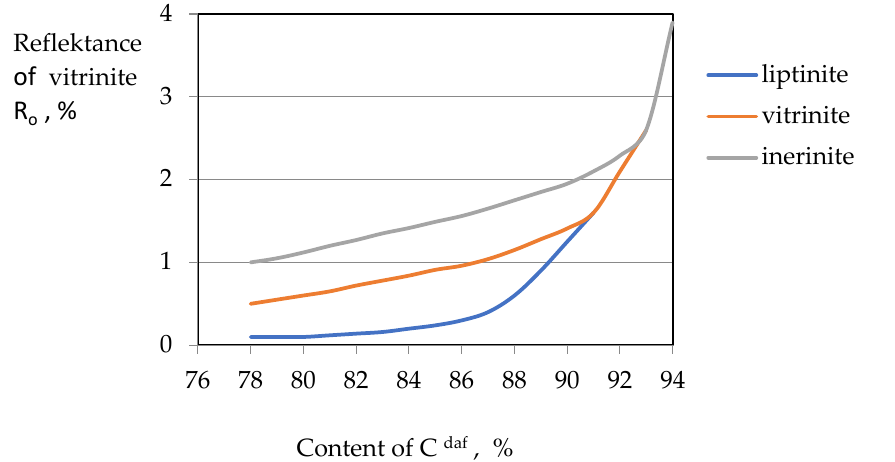
Figure 2. Variability of macerals’ groups reflectivity in coals of different carbonization degree [70].